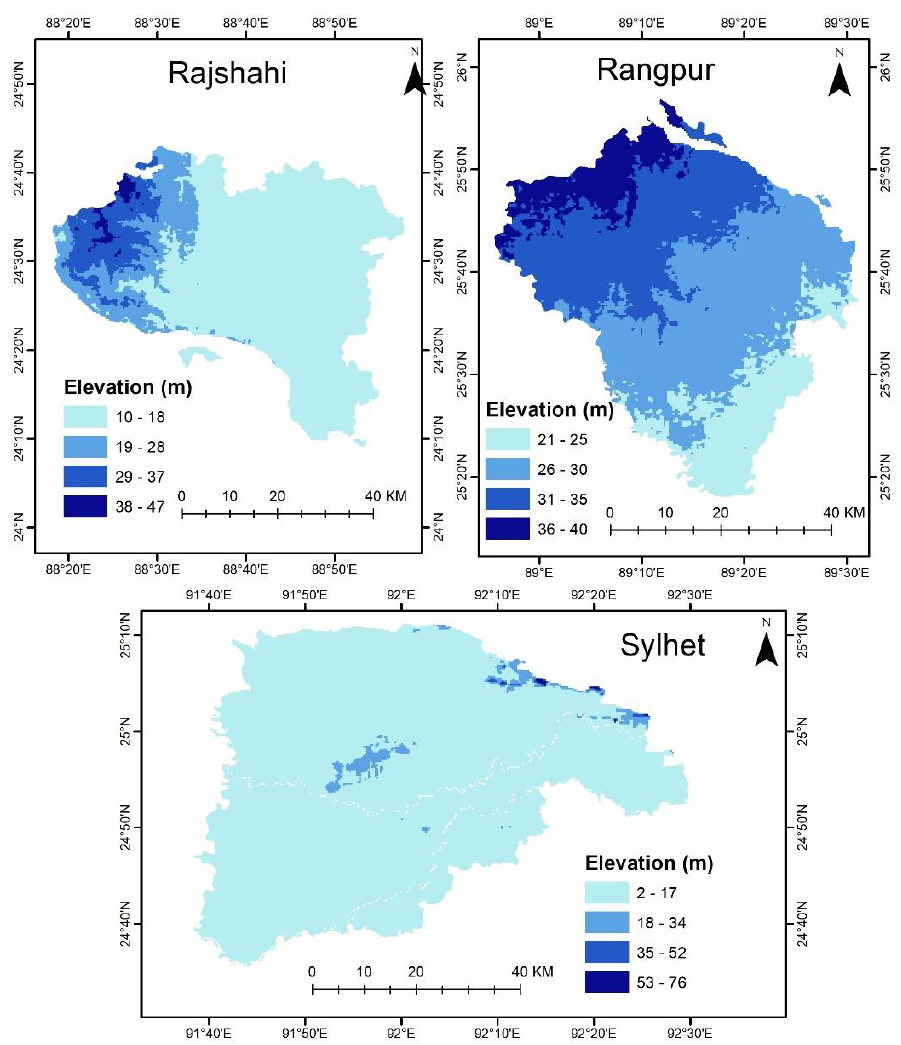
Figure 3. Study area showing remaining three districts including Rajshahi, Rangpur, and Sylhet in Bangladesh, among seven major districts (digital elevation model).